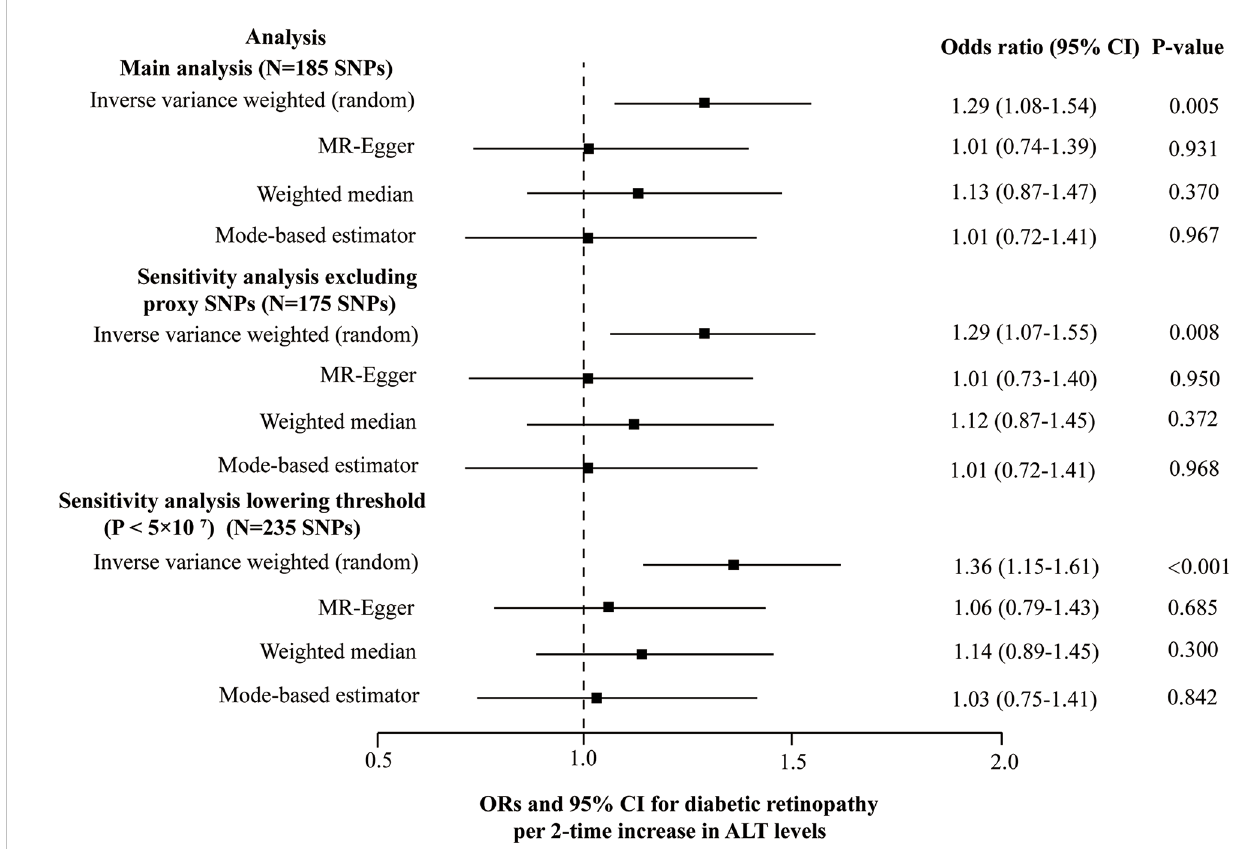
FIGURE 4 Forest plot of the MR main and sensitivity analyses of ALT and diabetic